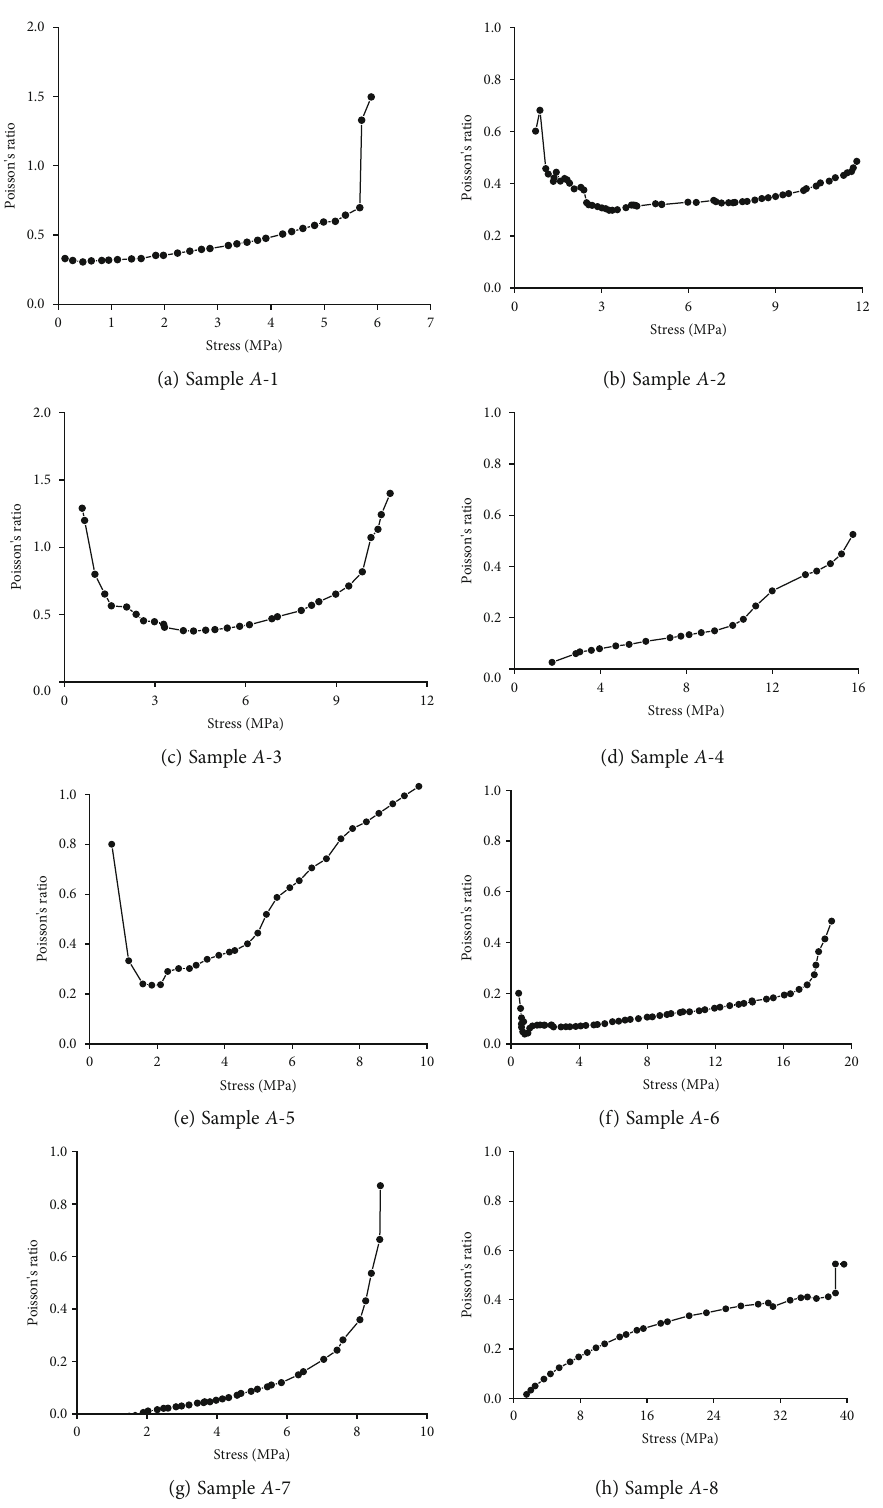
Figure 2: Poisson ’ s ratio of coal samples under di ff erent